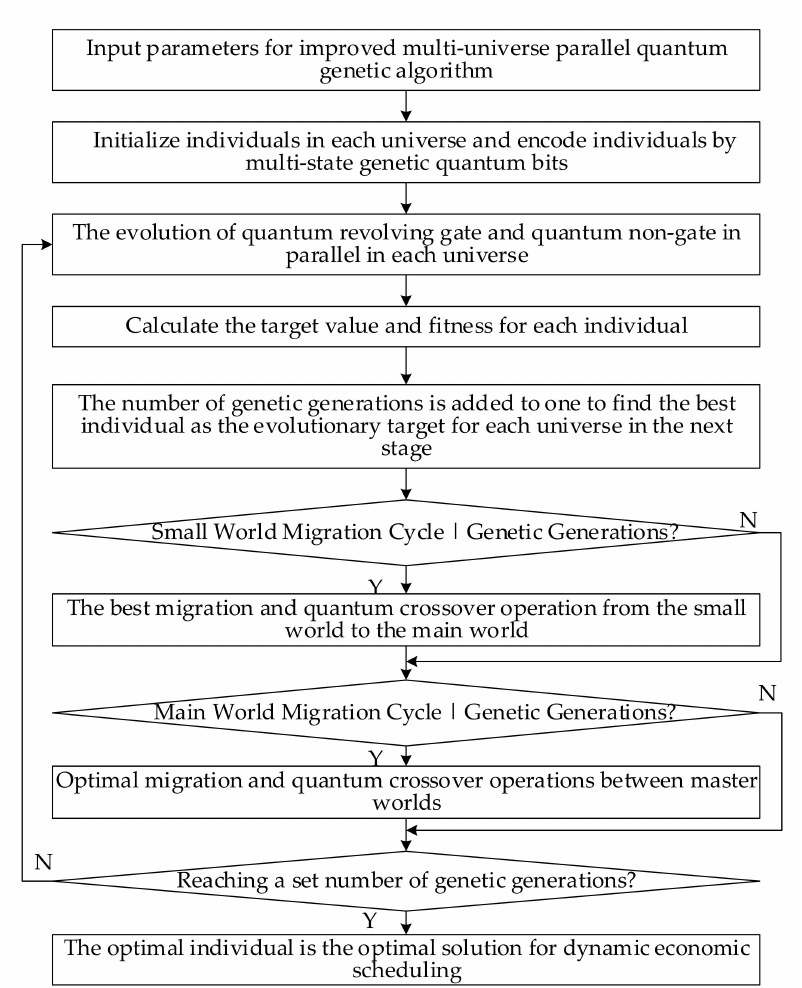
Figure 3. Flowchart of the improved multi-universe parallel quantum genetic